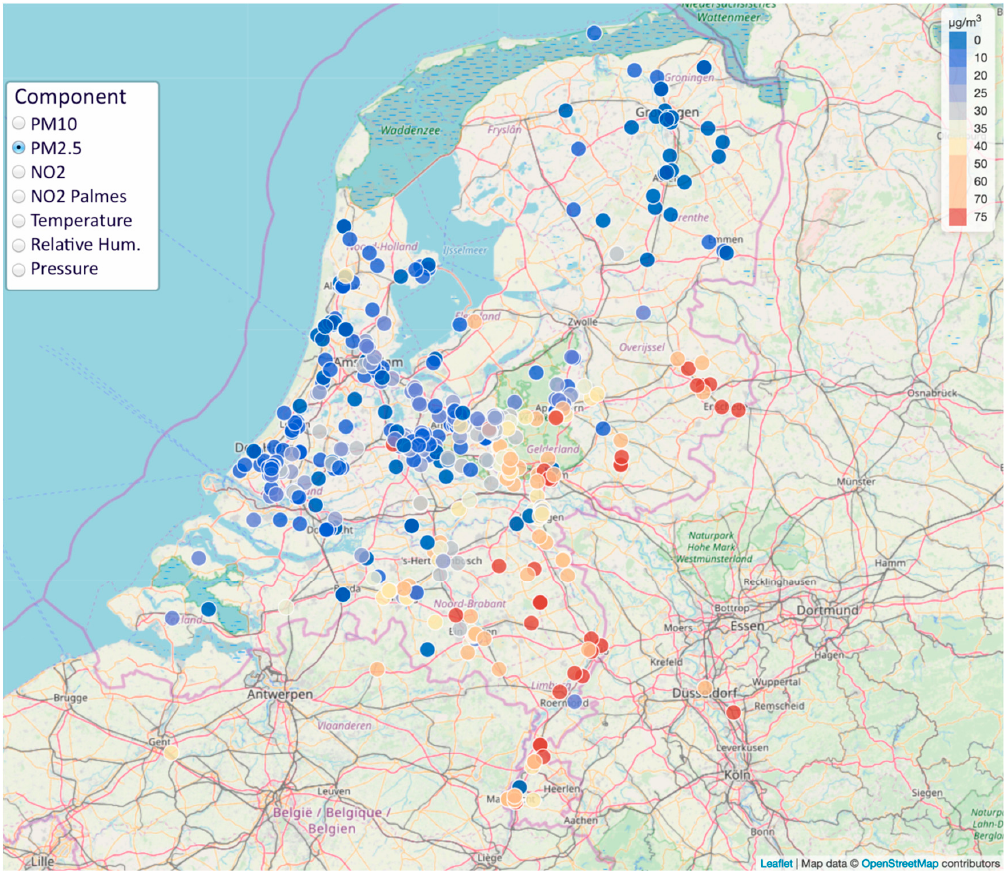
Figure 8. View of the “Measuring Together” data portal (samenmeten.rivm.nl), example from 26 June, 2019, when the figure was shown on the data portal. The sensors displayed on the portal show higher PM 2.5 concentration in the southeast of the country. The official measurements showed the same pattern.